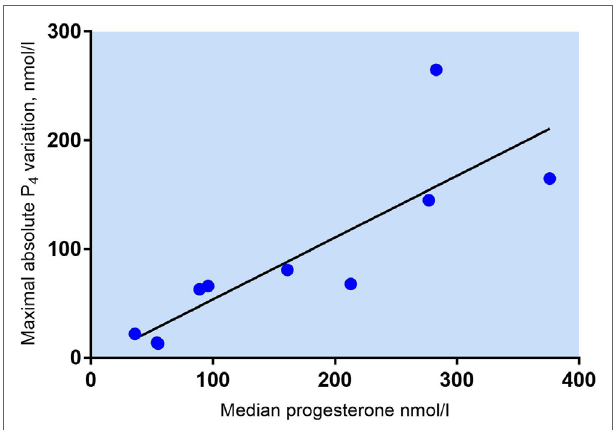
FigUre 3 | Maximum absolute variation in s-progesterone = P 4 maximum − P 4 minimum (nmol/l) in 10 patients undergoing in vitro fertilization treatment. Spearman’s r = 0.9273, p =